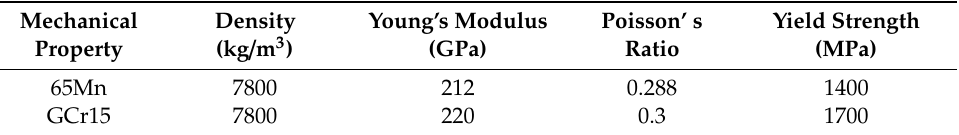
Figure 7. Time-displacement curve of the riveting head. Table 1. Mechanical properties of the quenched 65Mn and GCr15. Table 1. Mechanical properties of the quenched 65Mn and GCr15.